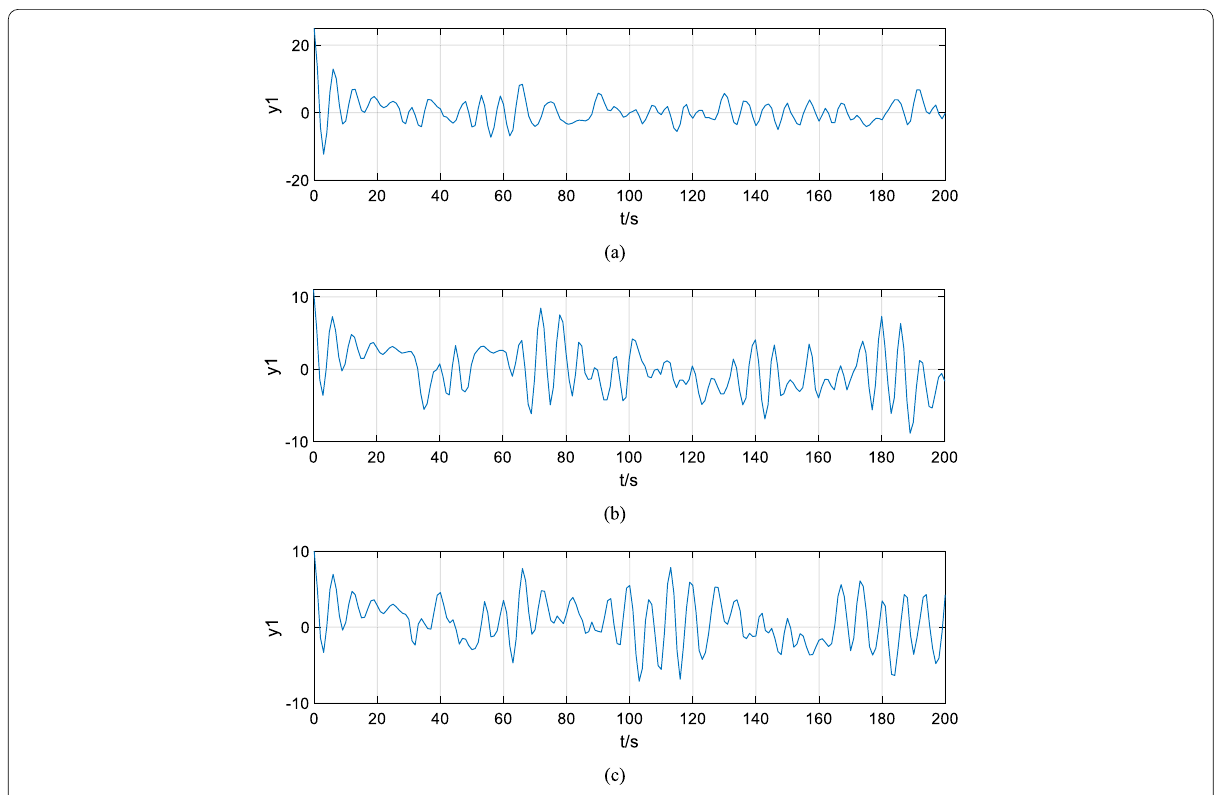
Figure 5 Operating states of the system under different bifurcation parameter values